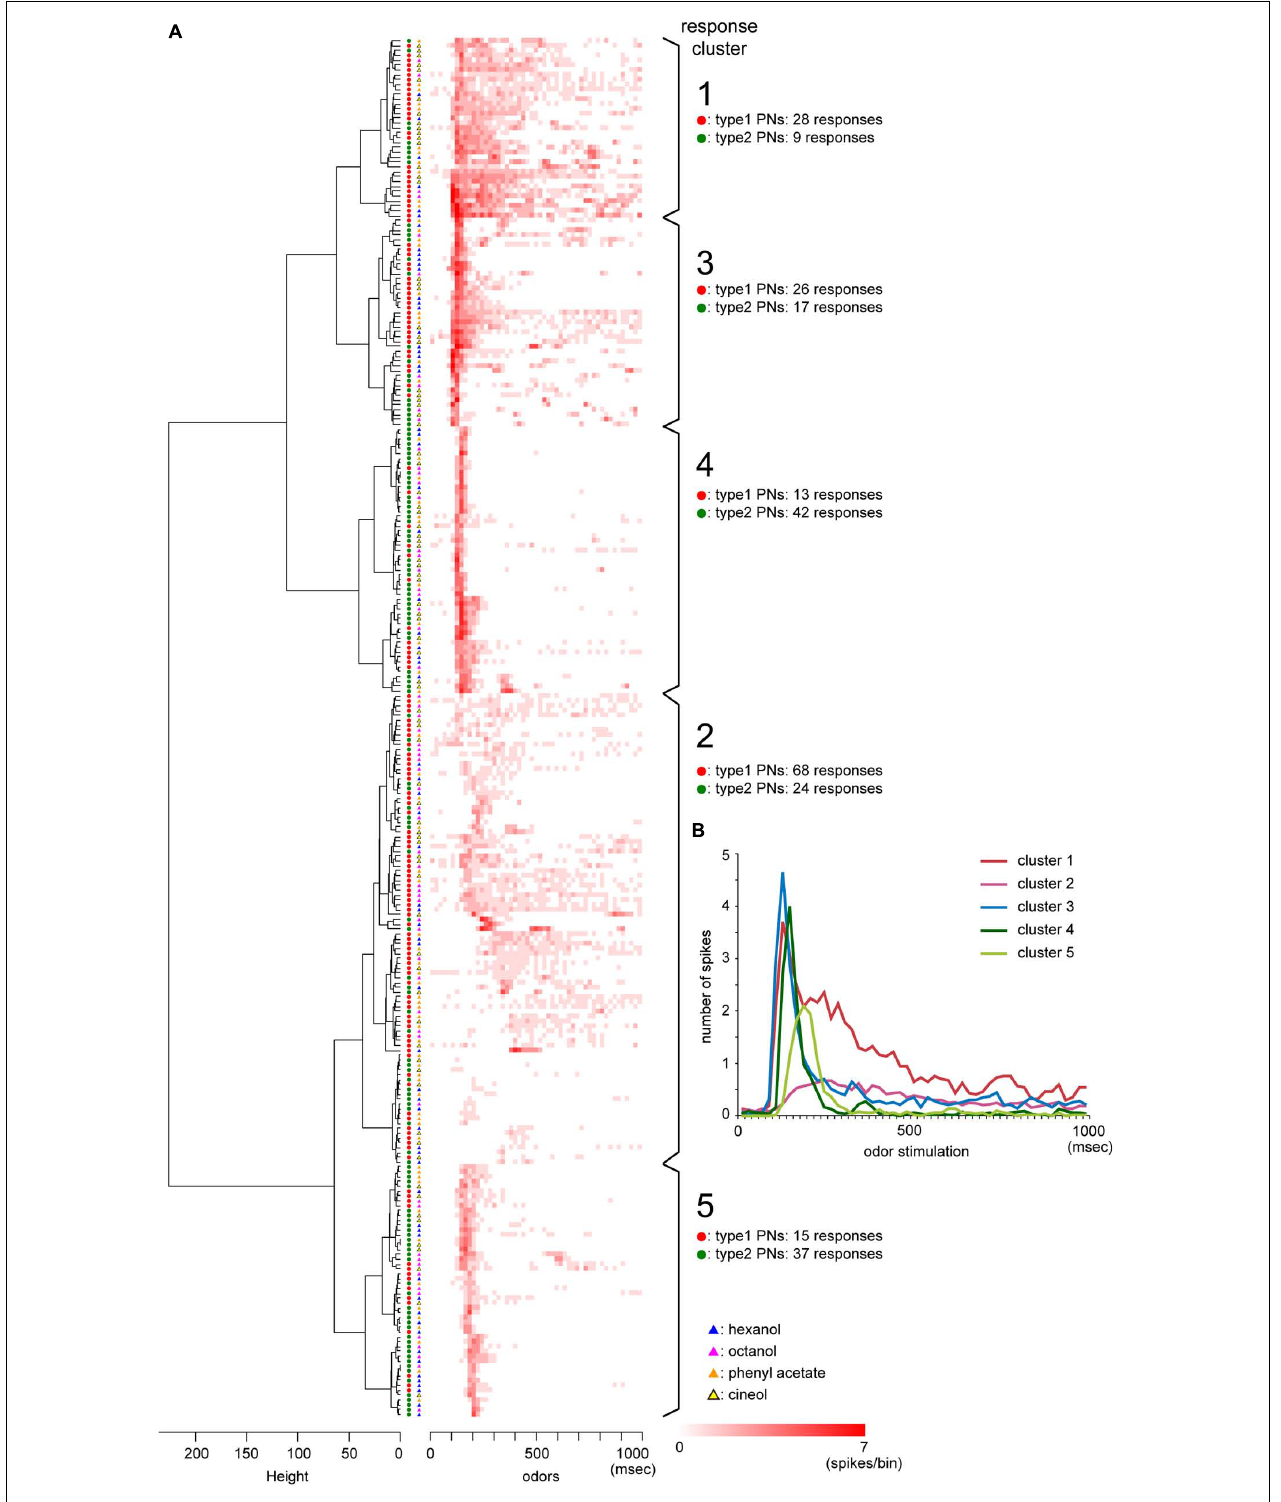
FIGURE 6 | Clustering of temporal activity patterns of PNs. (A) Results of cluster analysis. We classified temporal activity patterns of 284 PN responses into five response clusters based on the cluster dendrogram (left panel) formed by Ward’s method. The heat map shows PSTHs with a bin of 20 ms, and the heater color represents the higher spike activities within the bin. Red and green circles represent responses from type1 and type2 PNs, respectively. Responses to hexanol, octanol, phenyl acetate, and cineol are, respectively, denoted as blue, pink, orange, and yellow triangles. (B) Averages of PSTHs in each of five response clusters.